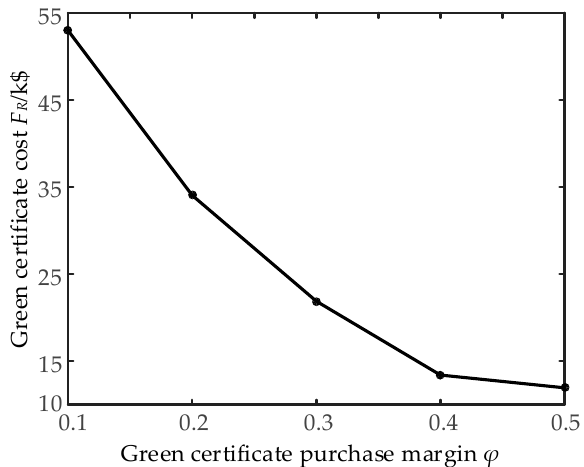
Figure 8. Green certificate cost with different purchase margin. 418